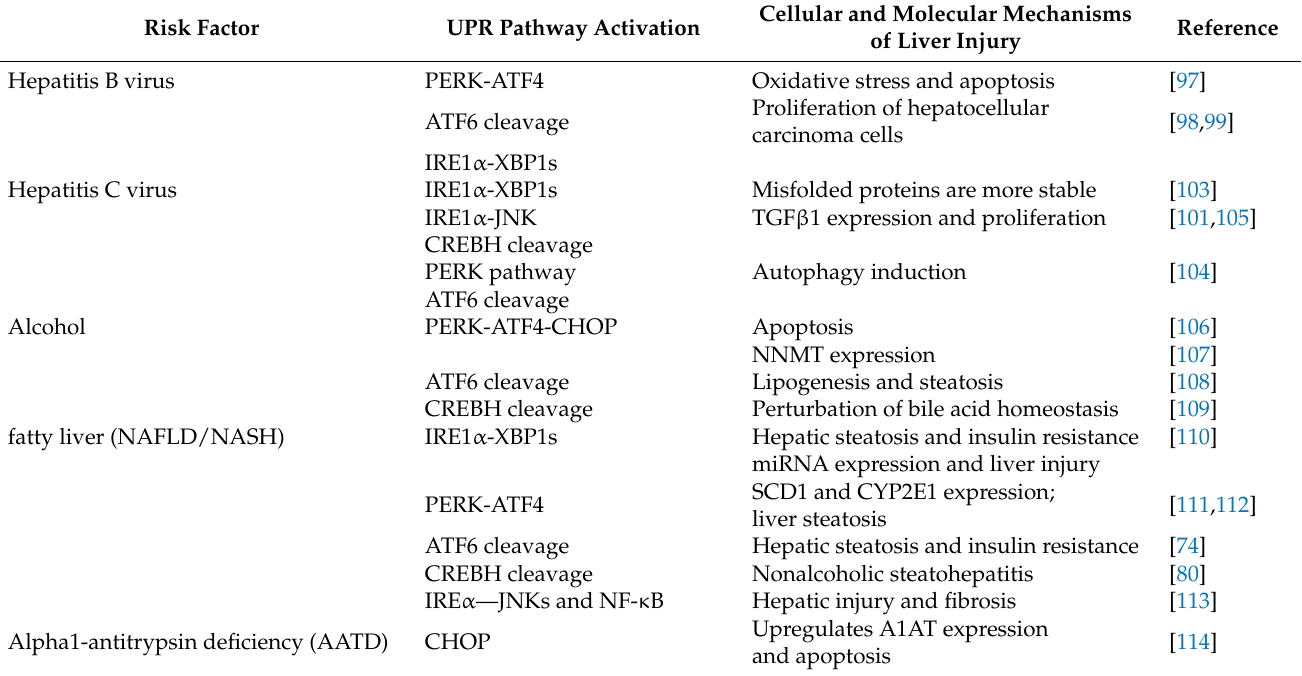
Table 1. ER stress in the pathogenesis of